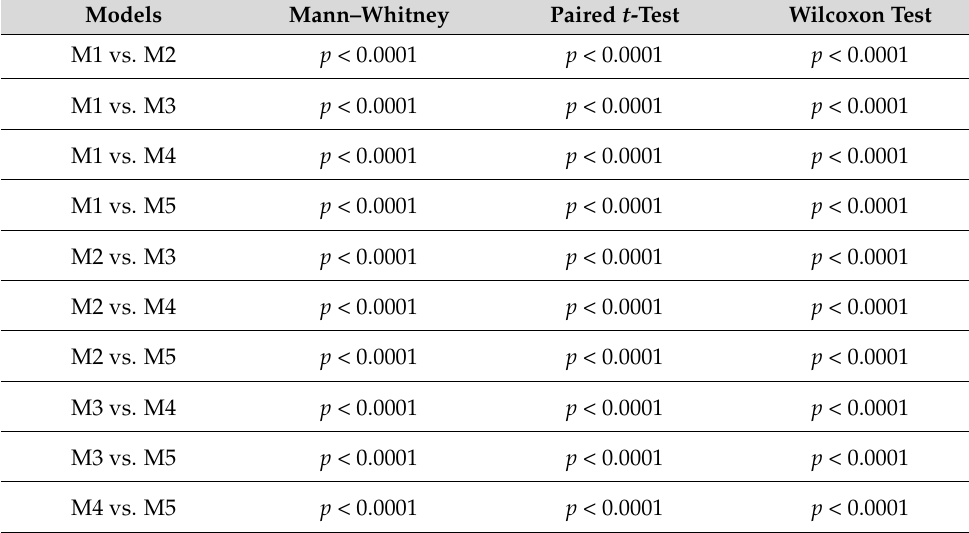
Table 8. Results of statistical